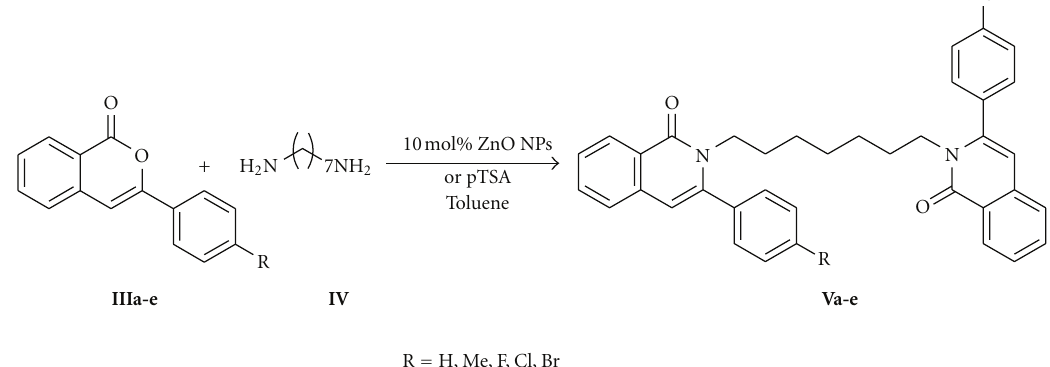
Scheme 2: Synthesis substituted bis-isoquinolinones Va-e .